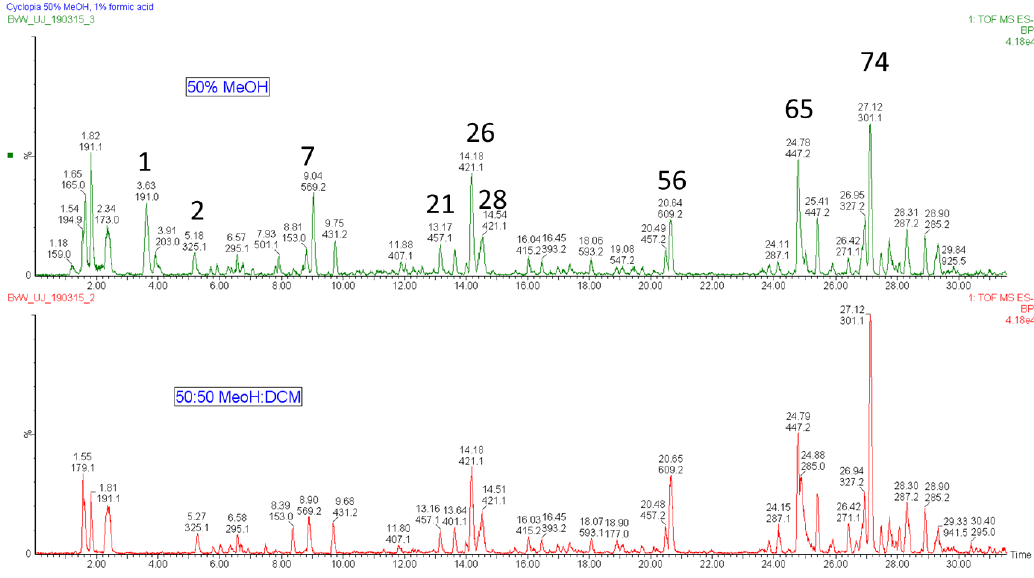
Figure 3. Total ion chromatogram of Cyclopia subternata extract of methanol / dichloromethane (1:1, bottom ) and 50% methanol, 1% formic acid ( top ) showing di ff erent extraction e ffi ciencies according to the polarity of the